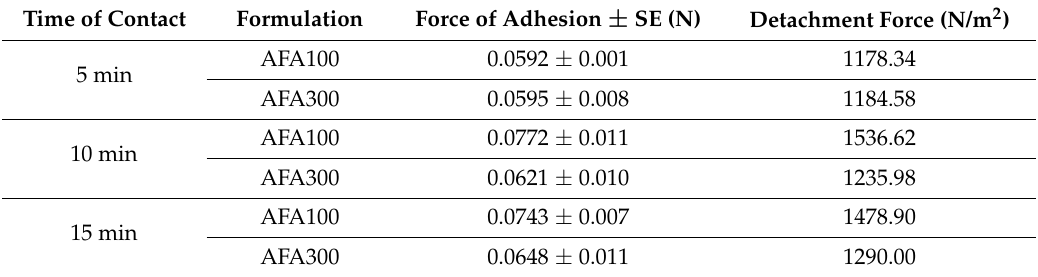
Table 4. Force of adhesion and Detachment Force of matrix Films as function of time contact with mucosa. Values are presented as means ±